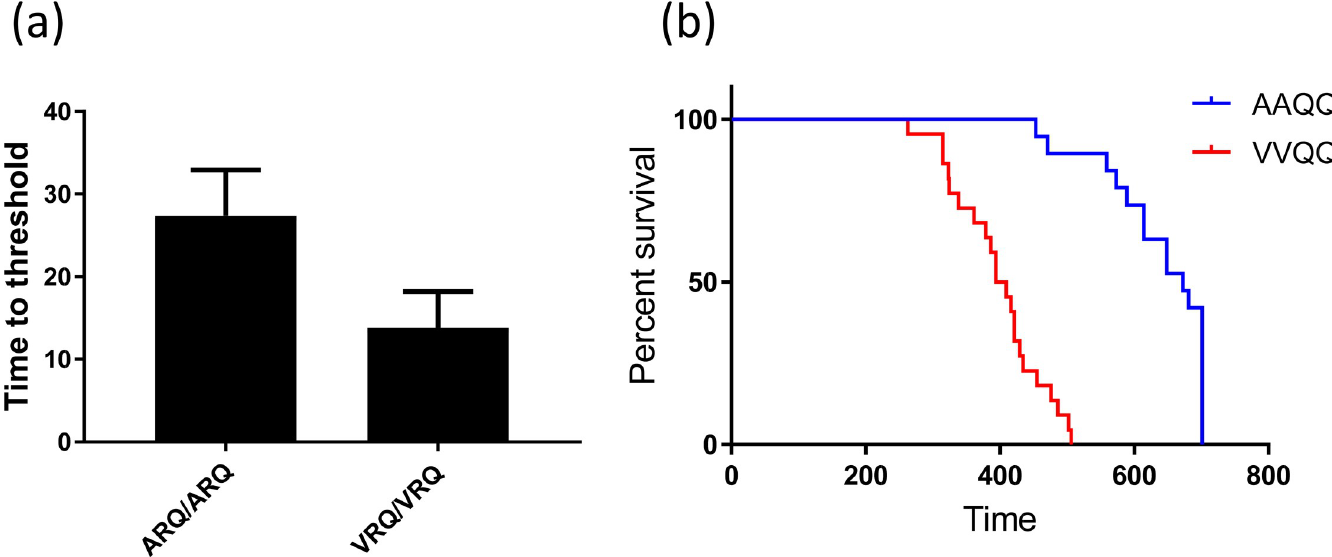
Fig 7. Comparison between average lag times obtained from RT-QuIC and incubation period from bioassay. A bar graph showing the mean and standard deviation for the average lag time for RT-QuIC reactions seeded with VRQ/VRQ and ARQ/ARQ. (b) Survival curve shows that Tg12 mice (132M) inoculated with a 1% brain homogenate of the scrapie inoculum from VRQ/VRQ sheep have a shorter mean incubation period than mice receiving inoculum from ARQ/ARQ